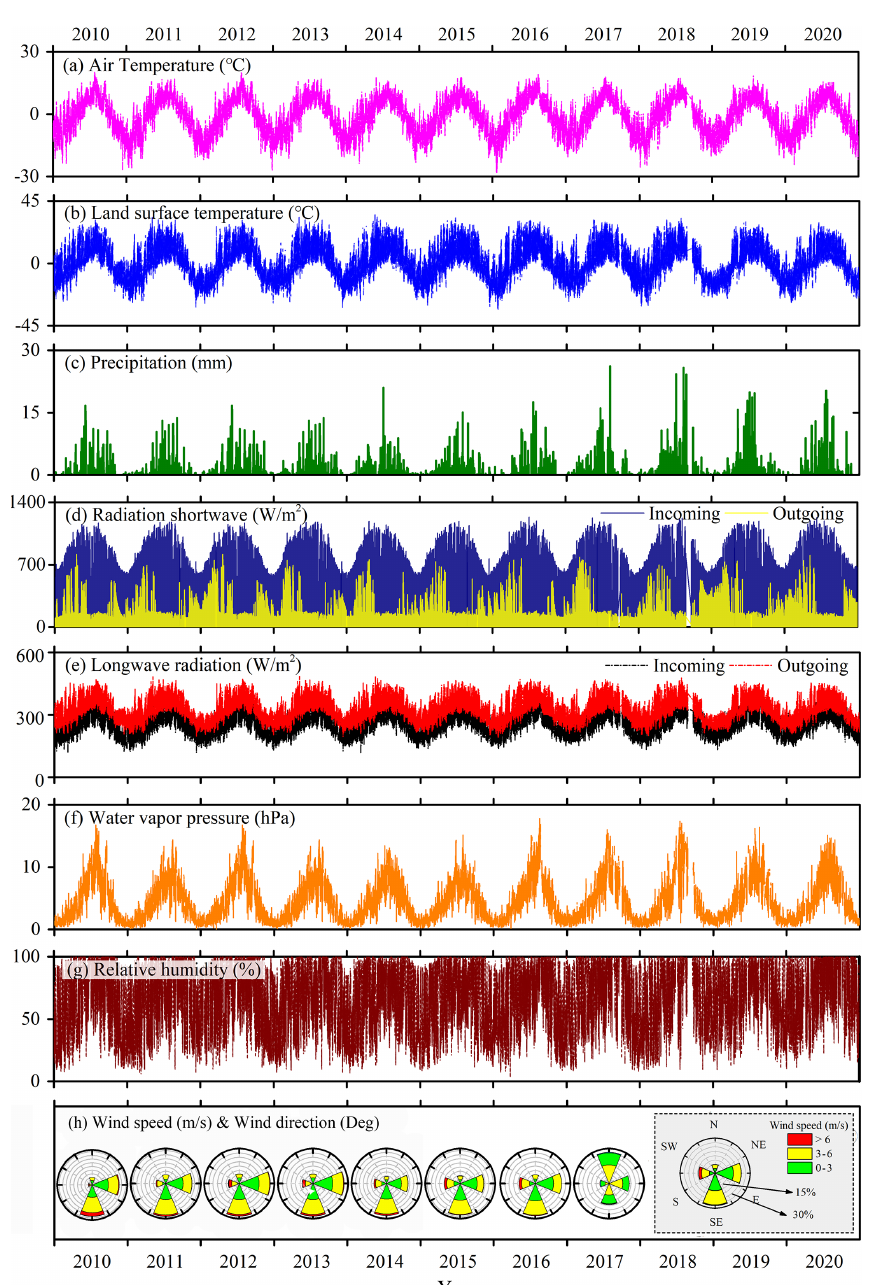
Figure 3. Time series of meteorological variables from 2010 to 2020 at the Mahan Mountain, including air temperature at 2m height (a) , land surface temperature (b) , precipitation at 1.6m height (c) , shortwave radiation at 2m height (d) , longwave radiation at 2m height (e) , water vapor pressure at 4m height (f) , relative humidity at 4m height (g) , and wind speed and direction at 2m height (h) . The temporal resolution of precipitation data is daily scale, and hourly scale for all other